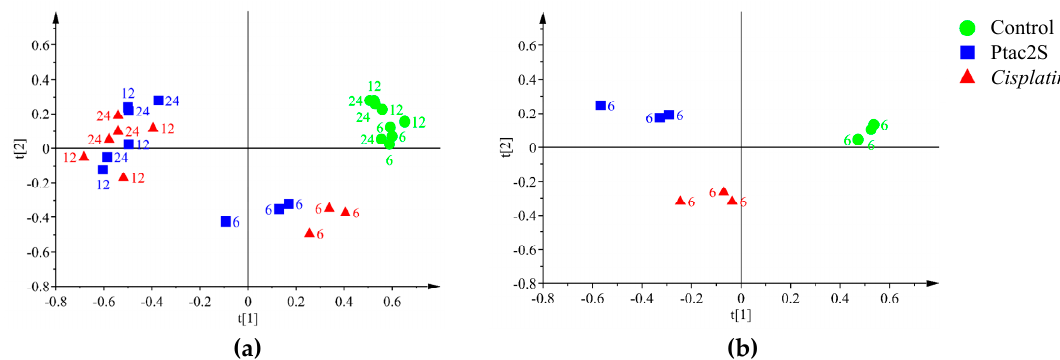
Figure 3. PCA score scatter plot of the 600 MHz 1 H-CPMG-NMR spectra (Pareto scaled) obtained from aqueous extracts of Ptac2S and cisplatin treated SKOV-3 cells in comparison with the untreated control samples. The indicated labels are referred to the culture times. ( a ) PCA t[1]/t[2] (four components give R 2 X = 0.862, Q 2 = 0.79). ( b ) PCA t[1]/t[2] scores scatter plot (two components give R 2 X = 0.865, Q 2 = 0.754).